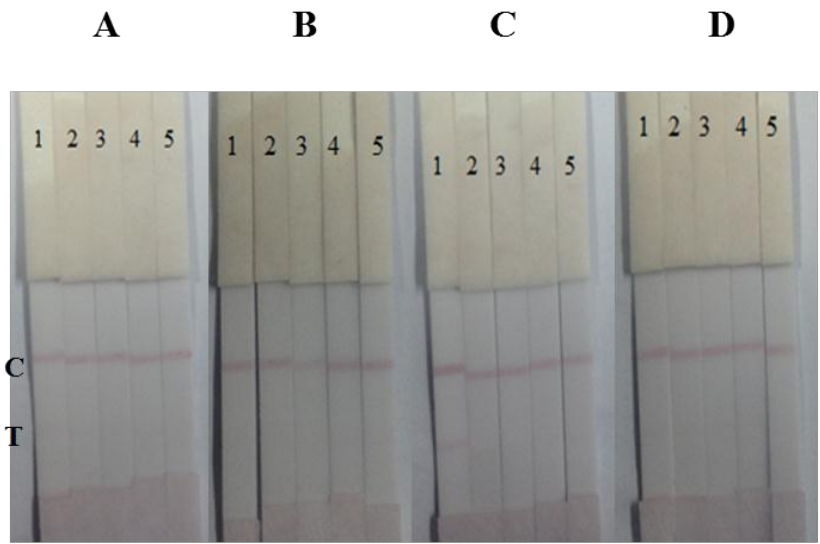
Figure 5. The cross-reaction of the immunochromatographic strip ( A ) Burkholderia glumae NCPPB 3591; ( B ) Xanthomonas oryzae pv. Oryzicola NCPPB 1150; ( C ) Pseudomonas syringae pv.syringae NCPPB 2844; ( D ) Xanthomonas Oryzae pv.Oryzae NCPPB 3002; the concentration was as follows: (1) 1 × 10 8 , (2) 1 × 10 7 , (3) 1 × 10 6 , (4) 1 × 10 5 cfu/mL and (5) blank. T, test line. C, control line.